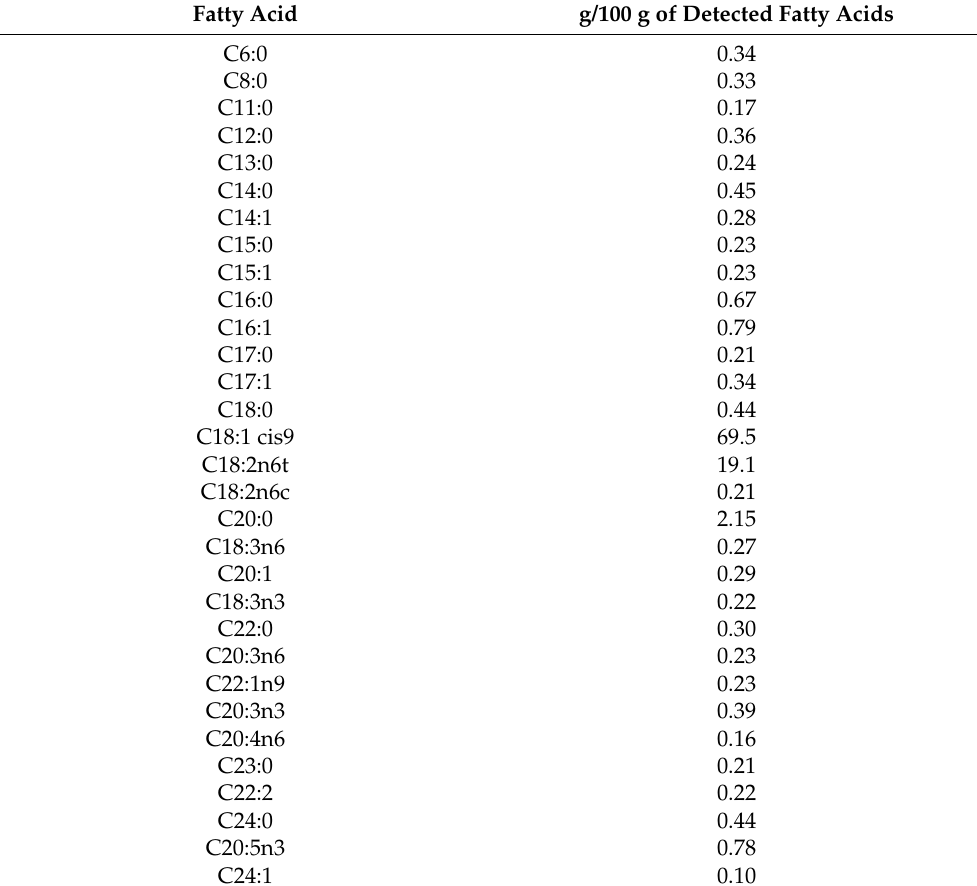
Table 1. Fatty acid profile of extra virgin olive oil used to feed growing